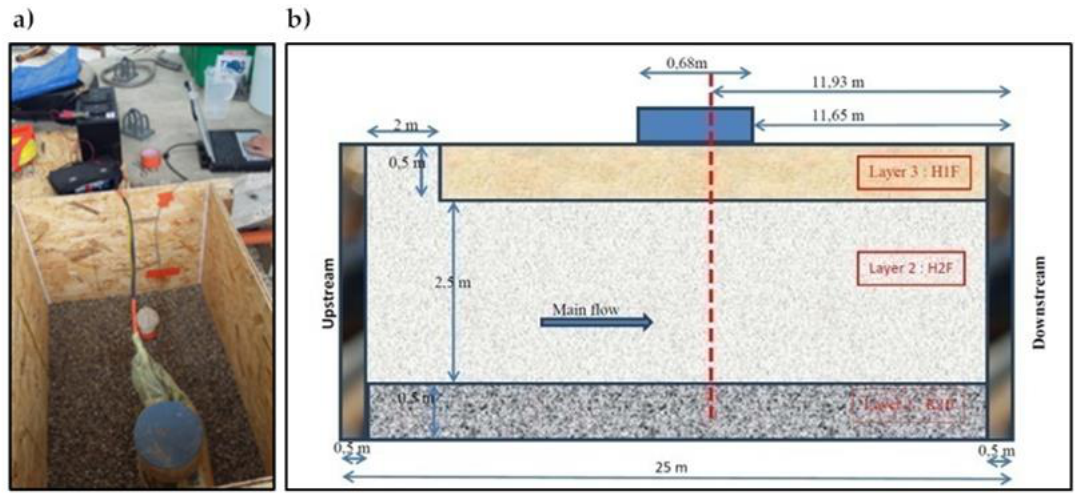
Figure 11. ( a ) Infiltration experiment with an 800 MHz antenna; ( b ) Sketch of the experiment site (Author’s own work) [56].